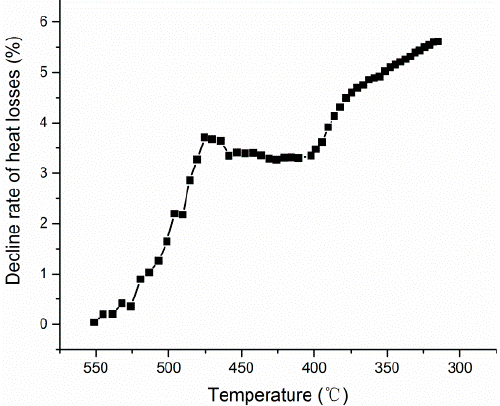
Figure 12. The rate of decline of heat losses caused by thermal stratification.